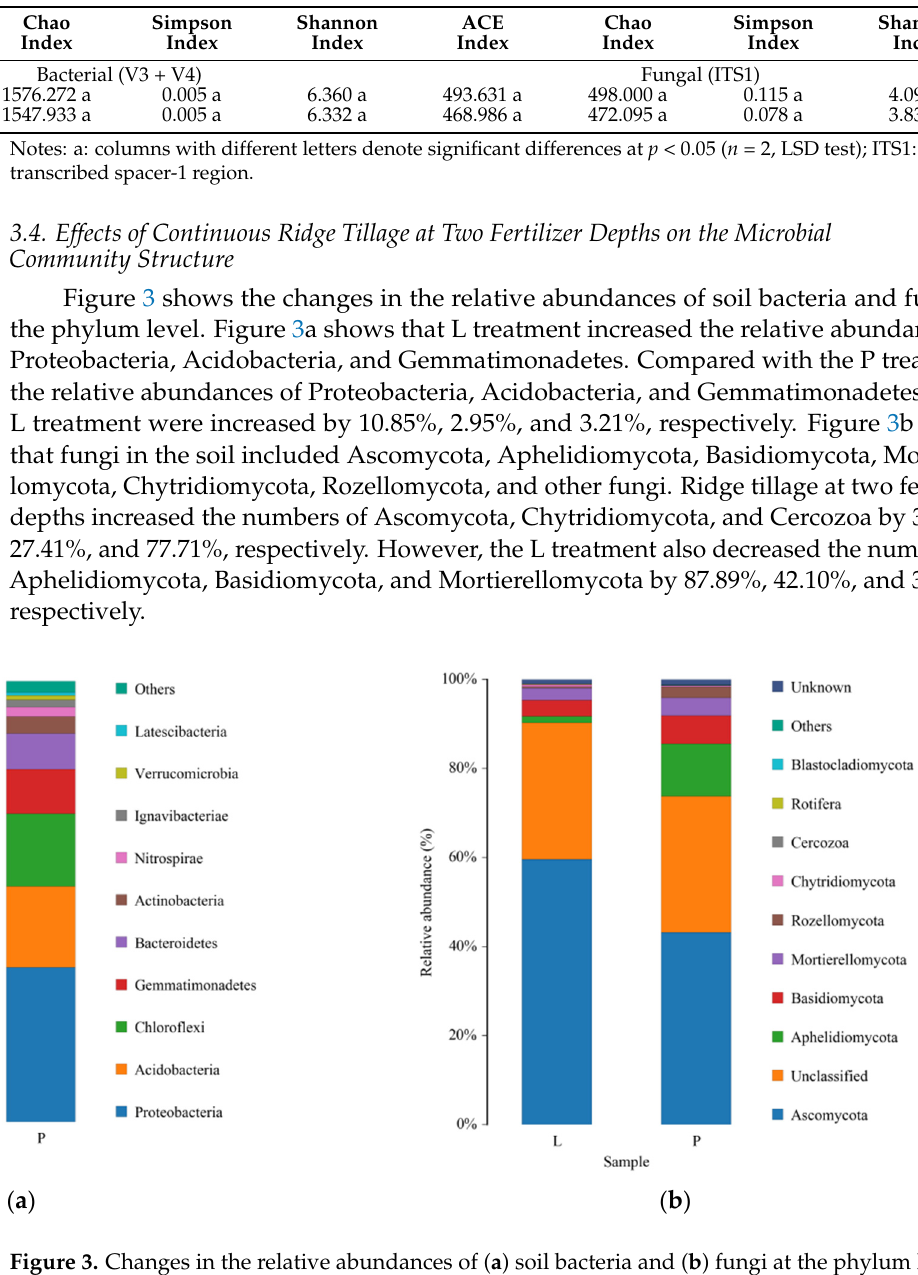
Table 6. The abundance and diversity of operational taxonomic units from soil samples.